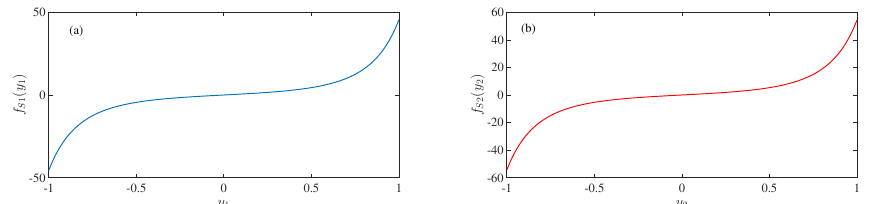
Figure 4. Plots of the magnetic spring force terms f S1 ( y 1 ) and f S2 ( y 2 ) with the variation of the ( a ) state-variable y 1 and ( b ) state-variable y 2 , respectively. In each of the figures, the x -axis is the non-dimensional displacements (i.e., state-variables y 1 and y 2 ) and the y -axis is the non-dimensional magnetic spring force terms. The parameter values are: D 1 = 1.5, δ 1 = 1, ( a ) b 1 = 45.7143, ( b ) b 2 = 54.5737. (Color Online).